Question: Looking at the figure, what chart type is it?
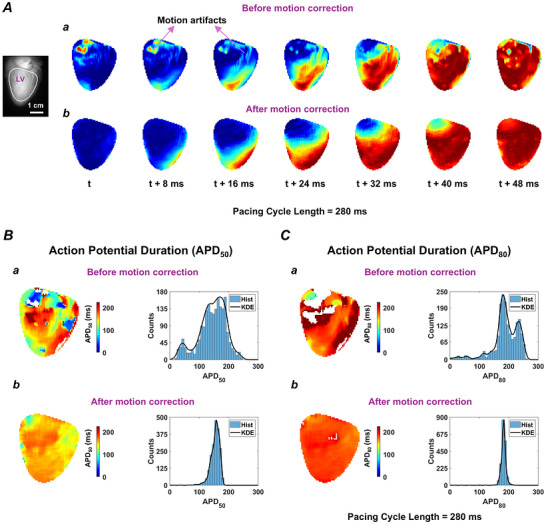
Answer: histogram